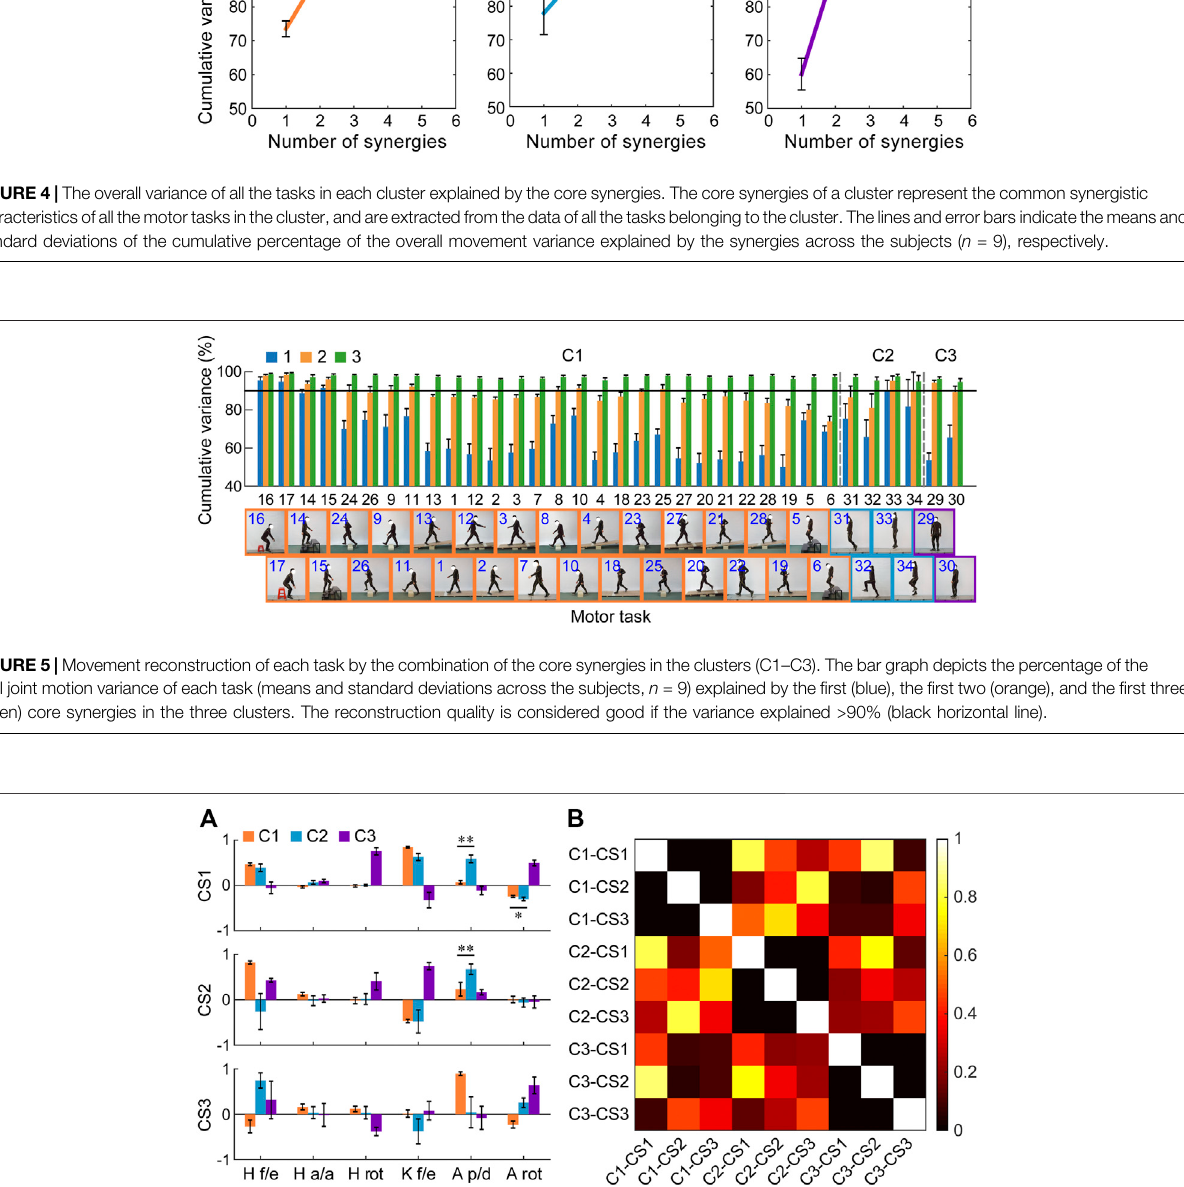
FIGURE 6 | (A) Core synergies of the three clusters (C1 – C3). The bars and error bars indicate the means and standard deviations across the subjects ( n (cid:1) 9), respectively.Beforeaveraging,thedirectionofthecoresynergiesinafewsubjectsisadjusted(i.e.,reversed)whenthesesynergiesarenotconsistentwithcorresponding referencesynergiesinareferencesubject(i.e.,whenthescalarproductbetweenthesynergyneedingtobeadjustedandthereferencesynergyislessthanzero).Flexion, adduction, internal rotation, and dorsi fl exion are de fi ned as positive values. * p < 0.01, ** p < 0.001 (two-tailed paired t -test). Abbreviations: CS1: the fi rst core synergy; CS2: the second core synergy; CS3: the third core synergy; H f/e: hip fl exion/extension; H a/a: hip adduction/abduction; H rot: hip rotation; K f/e: knee fl exion/ extension; A p/d: ankle plantar fl exion/dorsi fl exion; A rot: ankle rotation. (B) Similarity matrix of these core synergies (means across the subjects, n (cid:1) 9). The similarity between two synergies is quanti fi ed by the absolute value of their scalar product. Two synergies are considered signi fi cantly similar if their similarity > 0.7. Each of the abbreviations (from C1-CS1 to C3-CS3) represents a core synergy of a cluster. For instance, C1-CS1 represents the fi rst core synergy of the cluster 1.